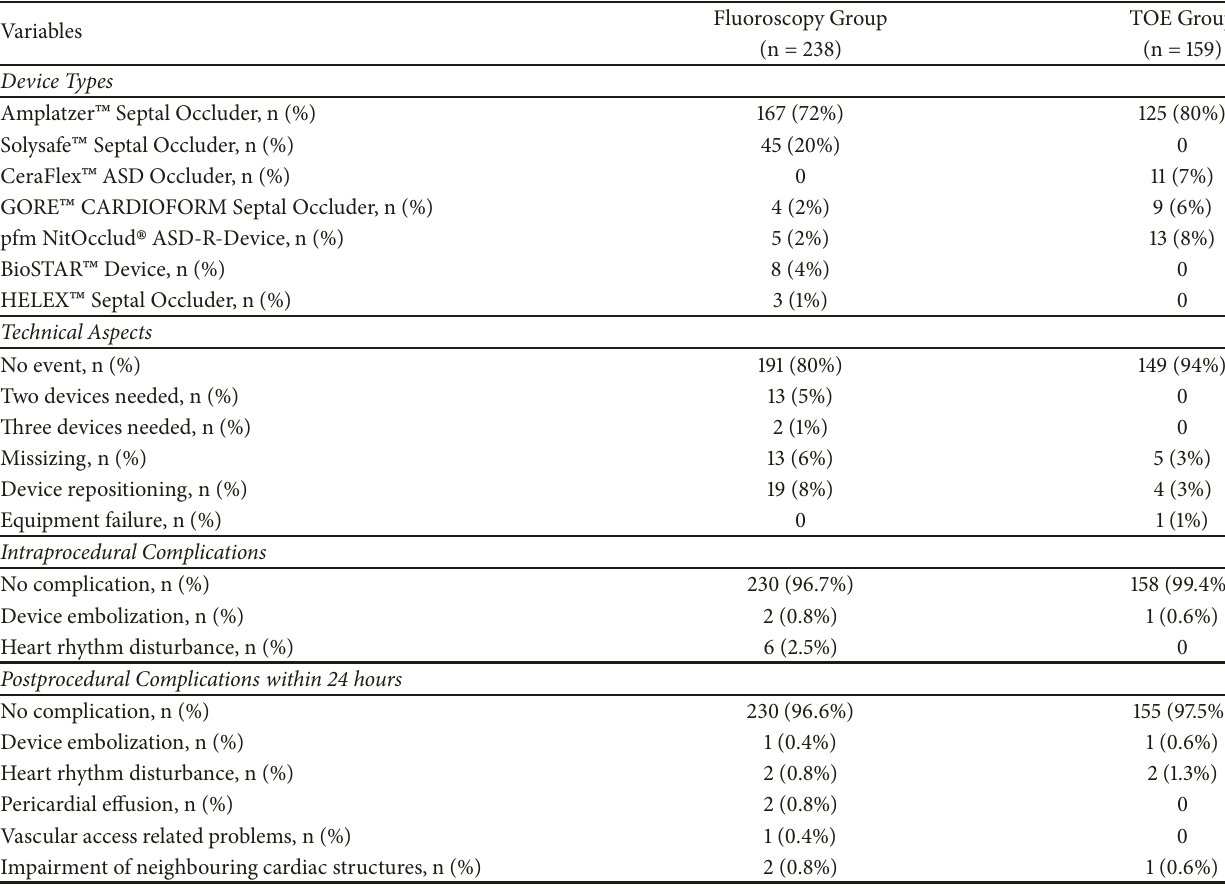
Table 2: Illustration of different device types used for interventional ASD device closure in both groups, technically challenging or special events occurring during cardiac catheter device closure procedures in both groups [significantly more events in the fluoroscopy group (p < 0.001)] and illustration of intraprocedural complications and complications within 24 hours after procedure in both